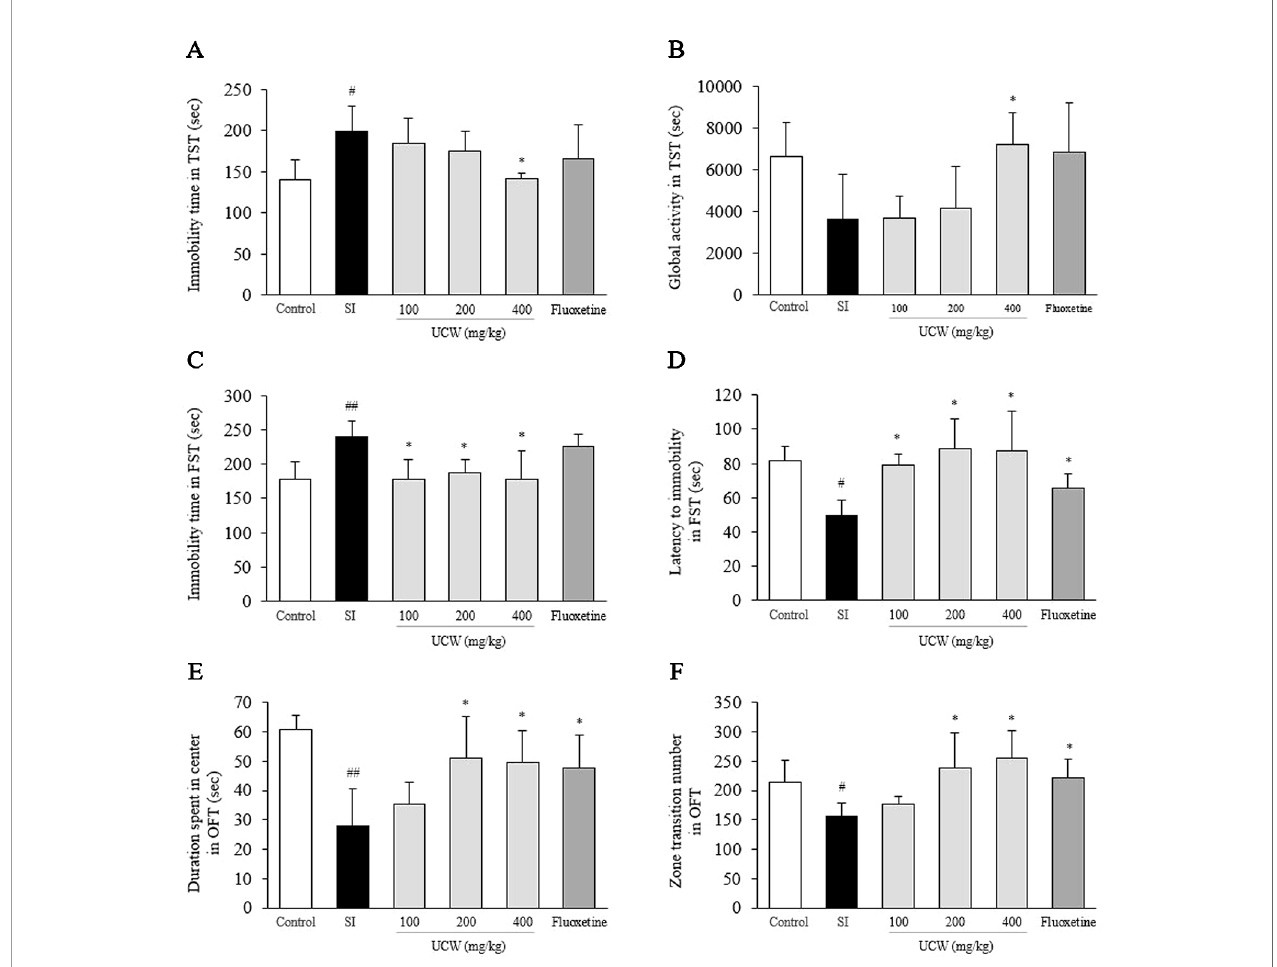
FIGURE 1 | Effects of UCW in depressive-like behavioral tests. After social isolation (31 days) with/without administration of UCW or fl uoxetine, the immobility time (A) and global activity (B) in the tail suspension test, the immobility time (C) and the latency to immobility (D) in the forced swimming test, and the duration spent in the center (E) and the zone transition number (F) in the open fi eld test were measured. *Data are presented as the mean ± SEM (n = 8). # P < 0.05, ## P < 0.01 compared with the control group; *P < 0.05, **P < 0.01 compared with the social isolation (SI)